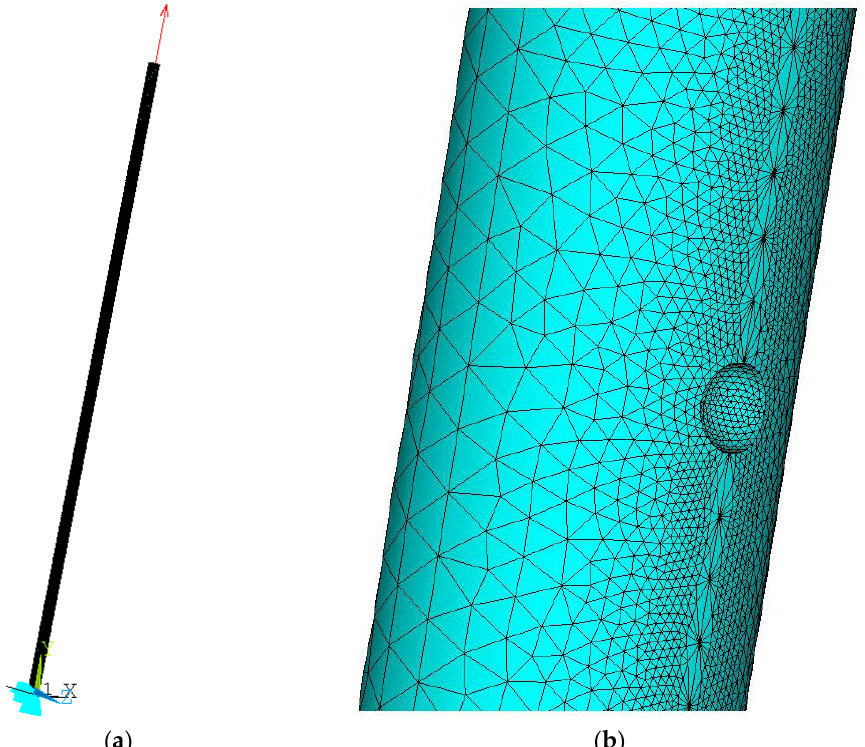
Figure 10. Finite element model of wire with a semi-spherical corrosion pit with a radius of 0.8 mm: ( a ) Loading definition; ( b ) Detail of a finite element model in the zone of the modelled pit.